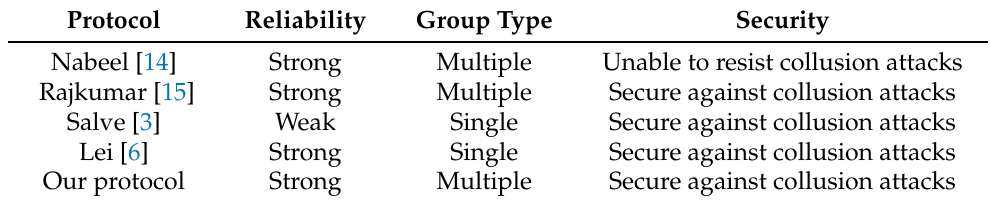
Table 3. Comparison with other